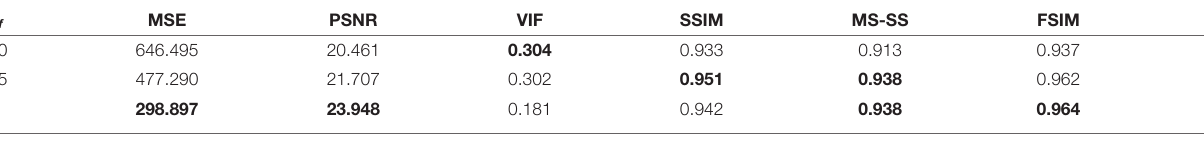
TABLE 3 | Quantitative comparison of different event frame times T f (ms).